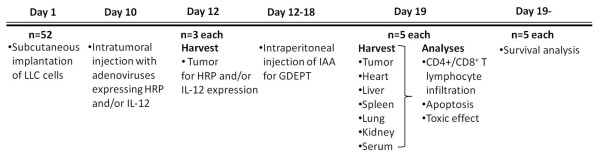
General outline of the in vivo experimentation with mouse model of LLC.